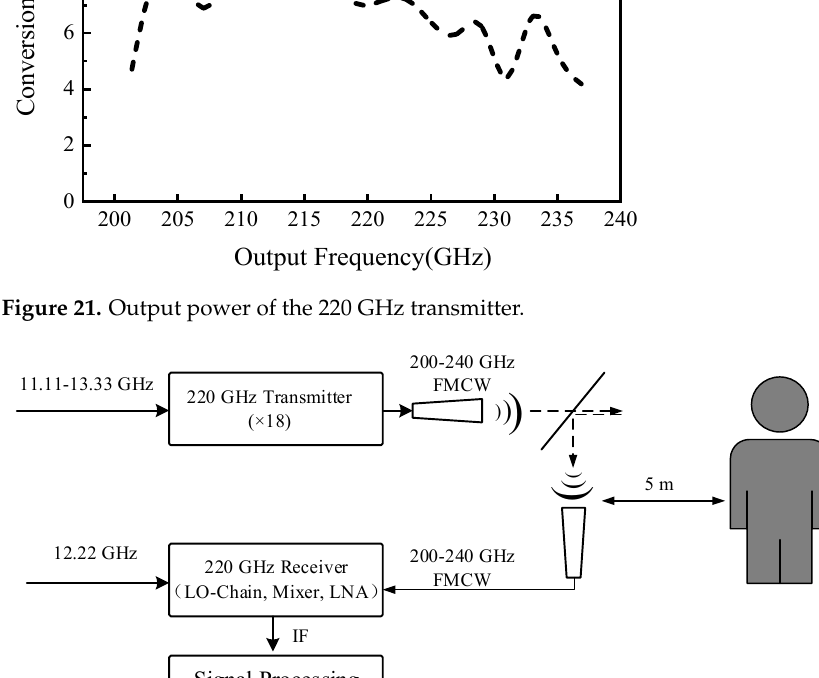
Figure 21. Output power of the 220 GHz transmitter.